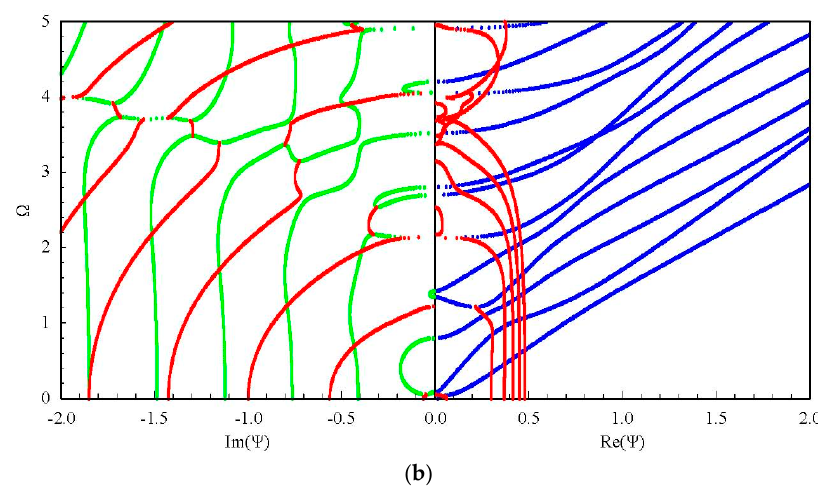
Figure 6. Frequency spectrum of a Lamb-like wave: ( a ) first quadrant curves; ( b ) 2D projection curves.